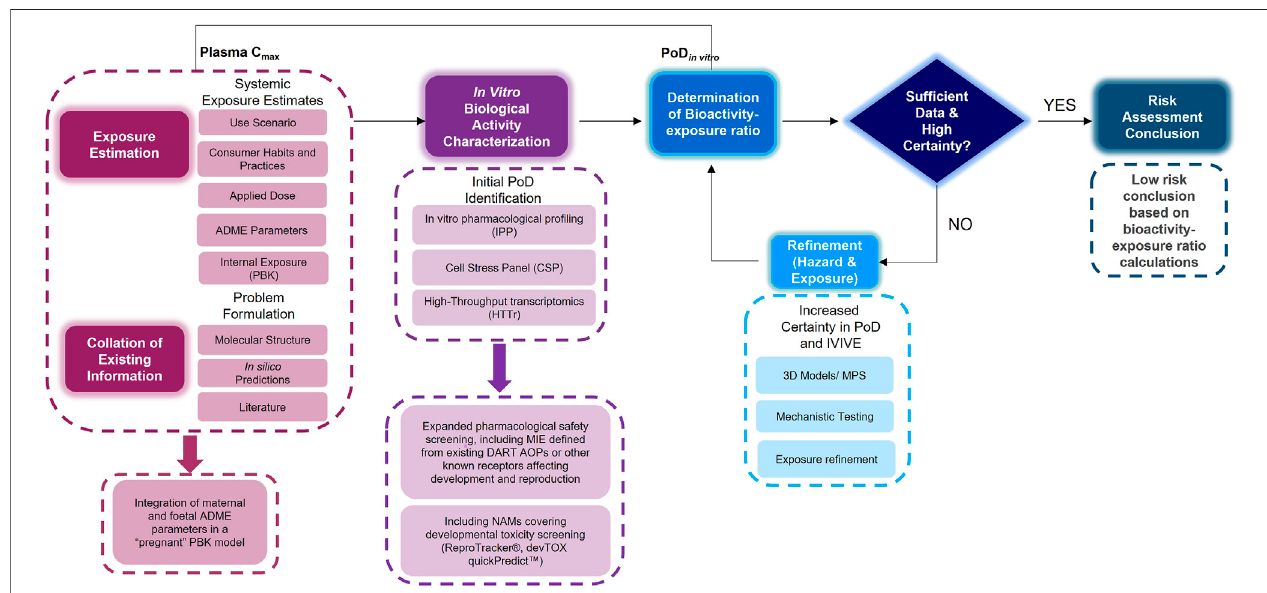
FIGURE 3 | An NGRA framework outlining the consideration of any existing information with exposure estimation including maternal and foetal ADME parameters with in vitro biological activity characterisation including additional NAMs relevant for DART endpoints to determinethe bioactivity exposureratio and further re fi nements to arrive at a risk assessment